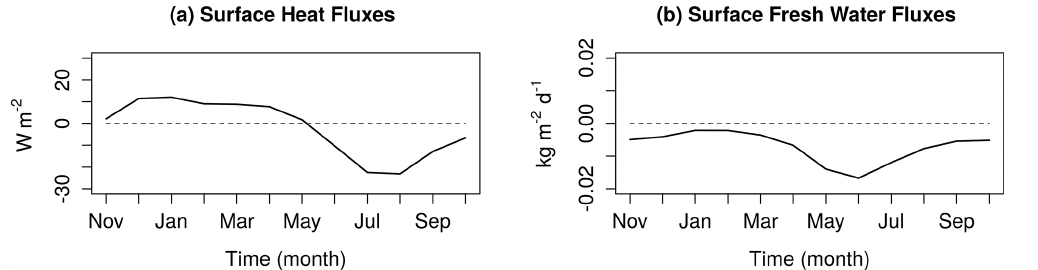
Figure 9. Labrador Sea (52–65 ◦ N, 58–43 ◦ W) monthly climatology of the nudging correction fluxes in RECON of (a) heat and (b) fresh- water. In both cases the fluxes are defined from the atmosphere into the ocean.